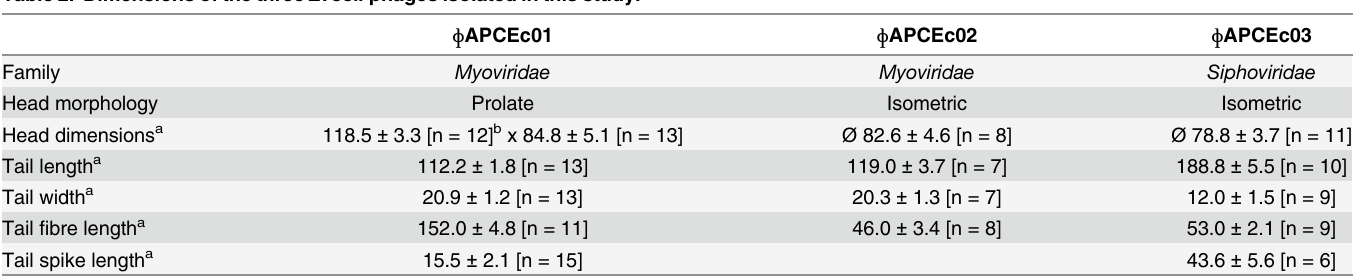
Table 2. Dimensions of the three E . coli phages isolated in this